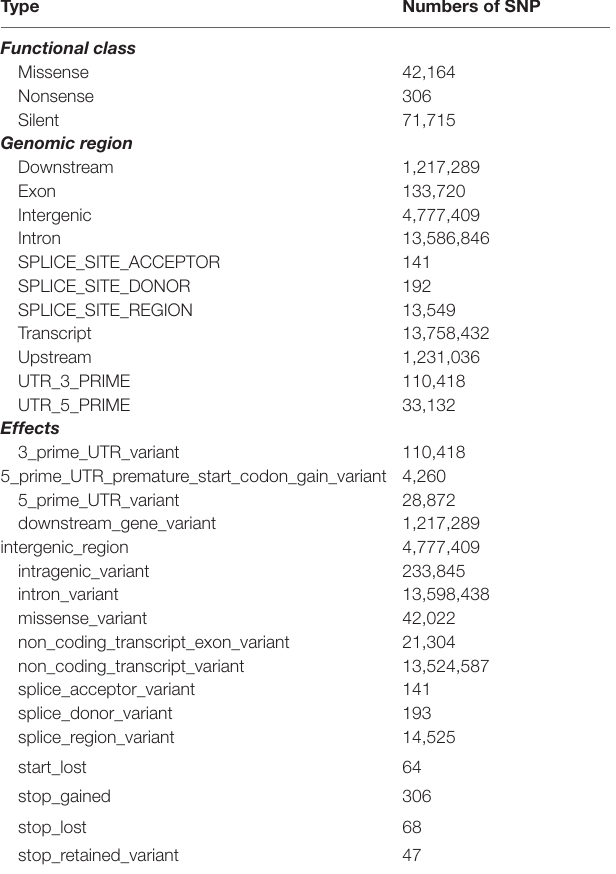
TABLE 4 | SNP annotation information in our